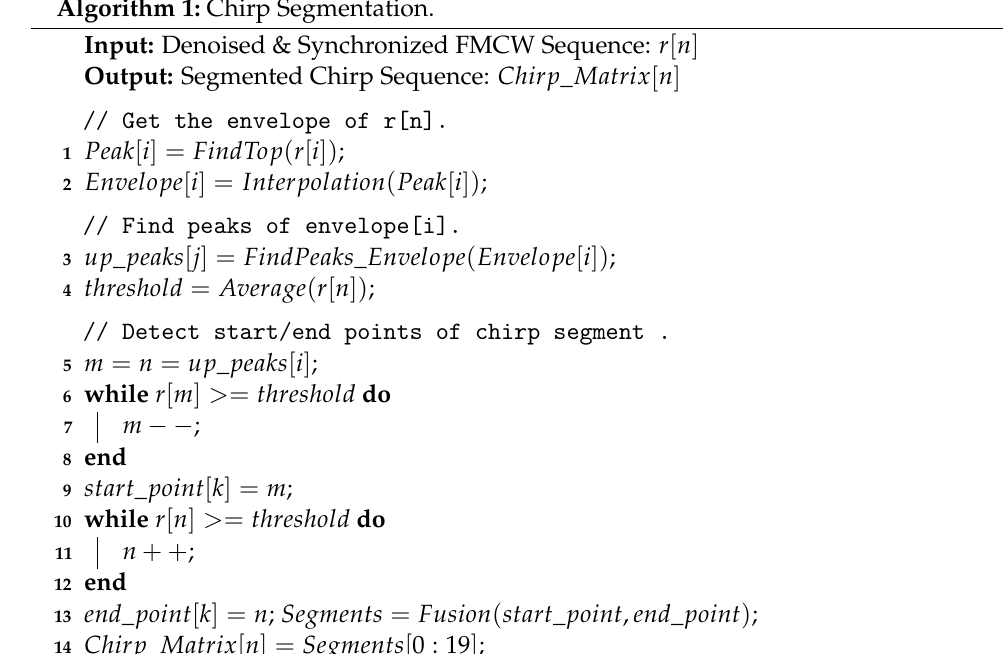
Algorithm 1: Chirp Segmentation.